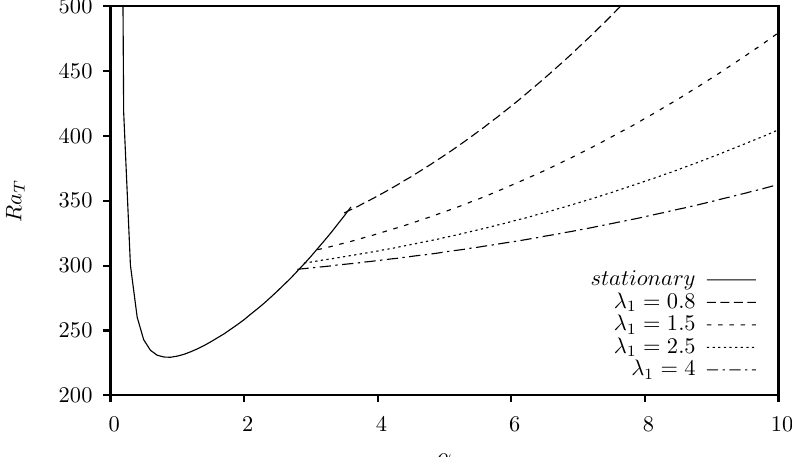
Figure 5. Effect of λ 1 on the marginal stability curves for oscillatory convection with respect to the wave number α